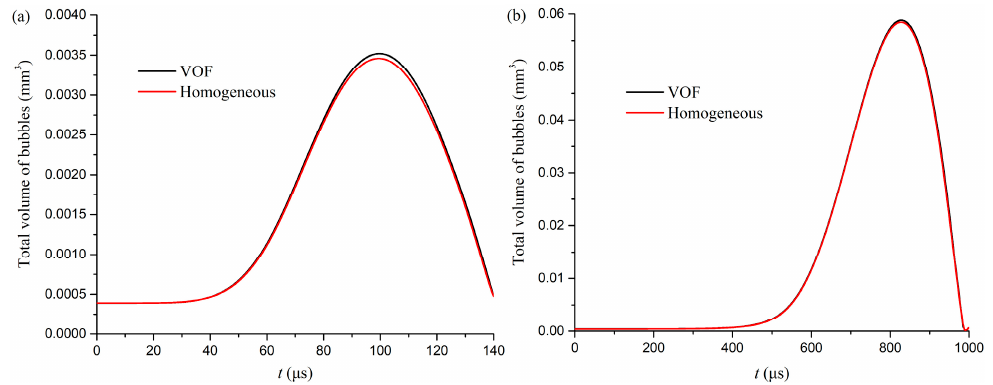
Figure 5. Volume of three gas bubbles predicted by the VOF method and homogeneous model. R 0 = 50 µ m, T 0 = 298 K, S = 0, n 0 = 10 9 m − 3 , p 0 = 101325 Pa, β T = 6.82, A p = 1.4, and t w = ( a ) 20 µ s and ( b ) 200 µ s.